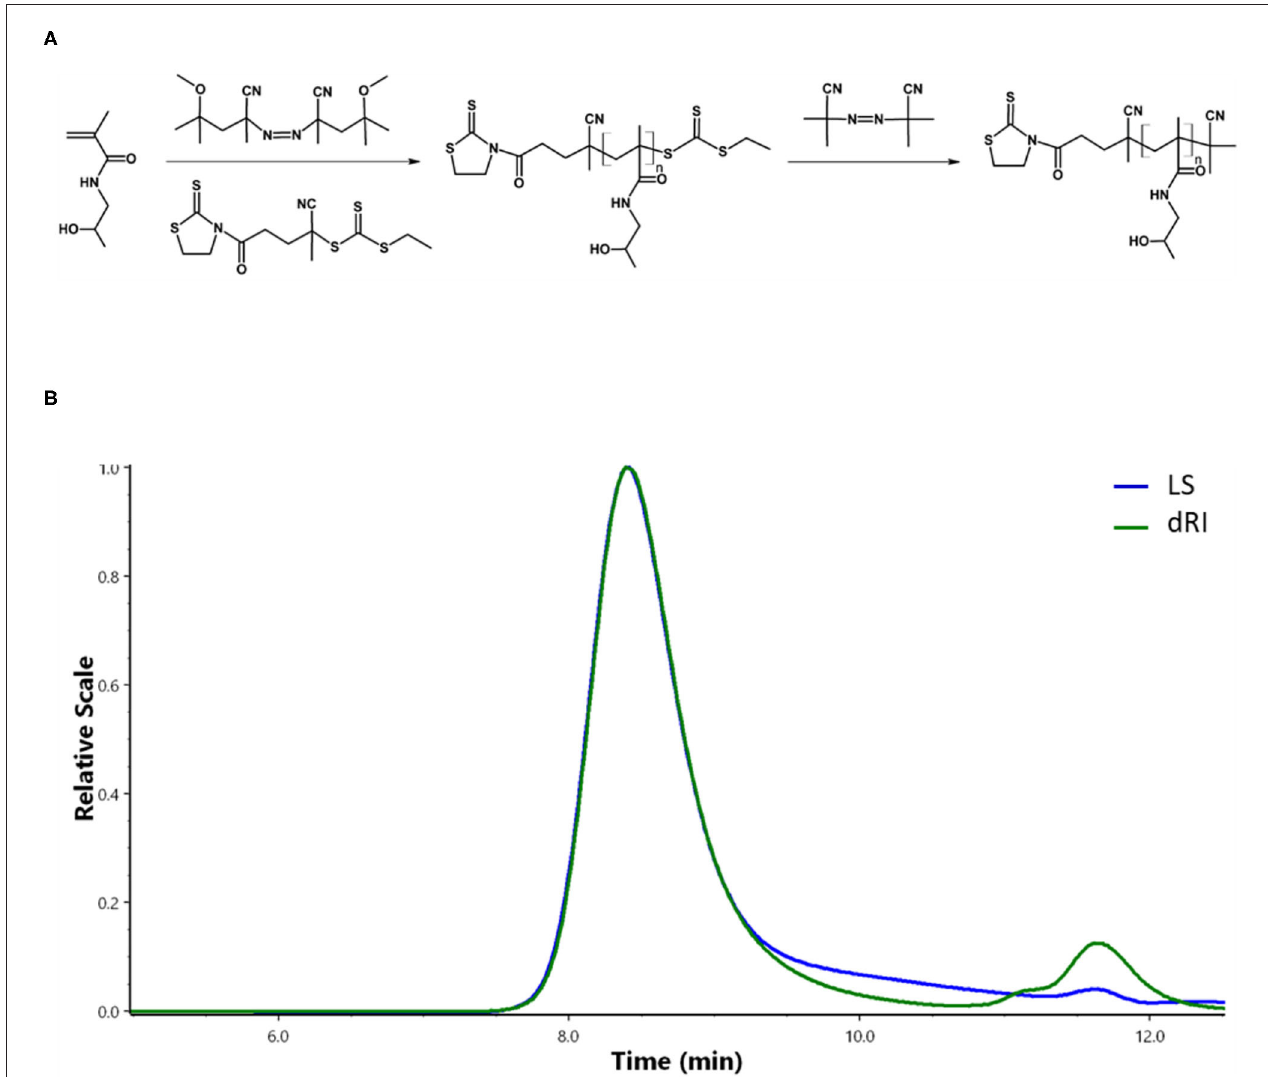
FIGURE 2 | Synthesis and characterizations of pHPMA. (A) RAFT polymerization of HPMA. (B) Chromatogram of pHPMA-TT from SEC.